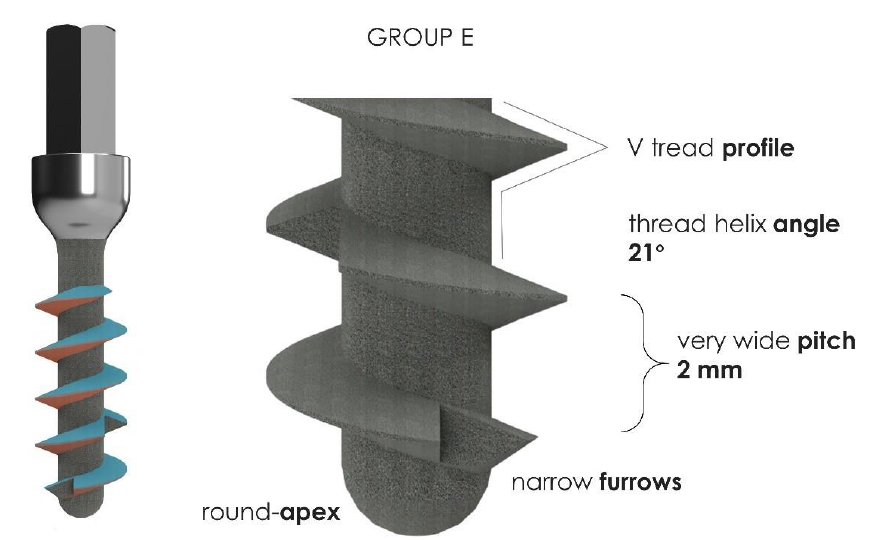
Figure 4. Group D: in detail, the morphology and thread geometry of the external hexagon cylindrical implants.